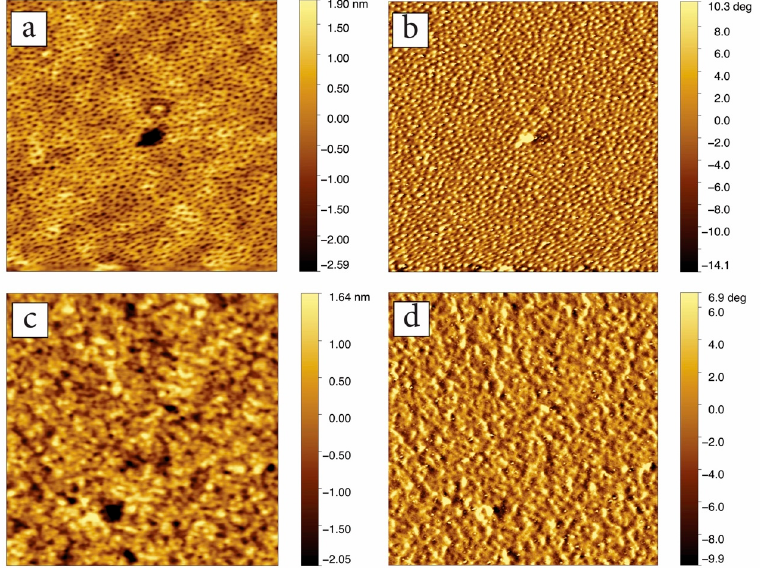
Figure 3. Scanning force microscopy (SFM) topography ( a , c ) and phase ( b , d ) images (1 μ m × 1 μ m) before ( a , b ) and after ( c , d ) in-situ measurements with ultra-pure water upon UV cleavage for 1 h.